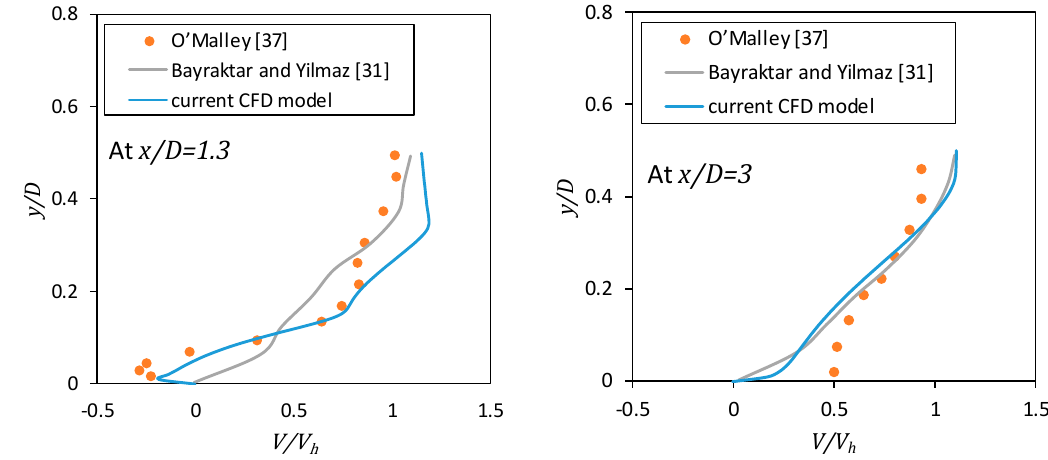
Figure 5. Experimental validation of velocity profile against O’Malley [37] experimental results.